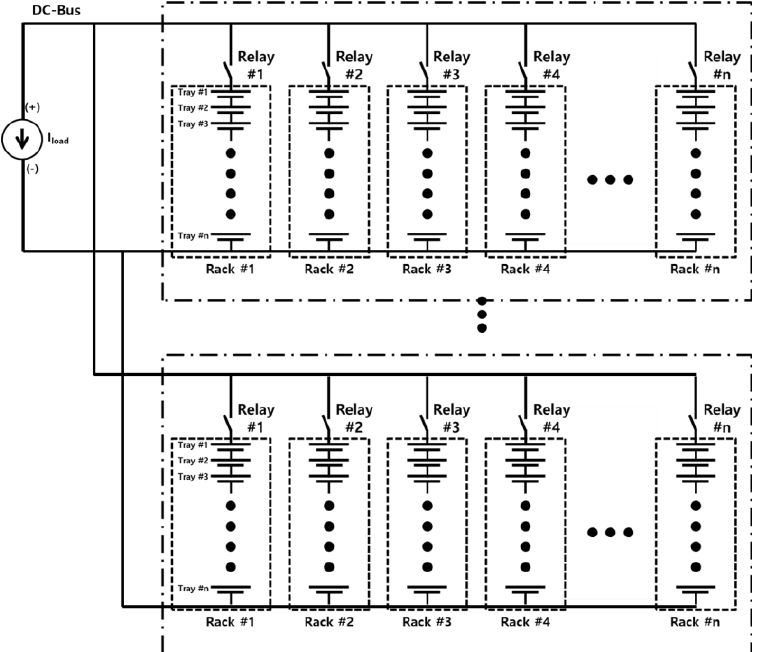
Figure 1. Large-capacity battery system consisting of high voltage modules connected in parallel.